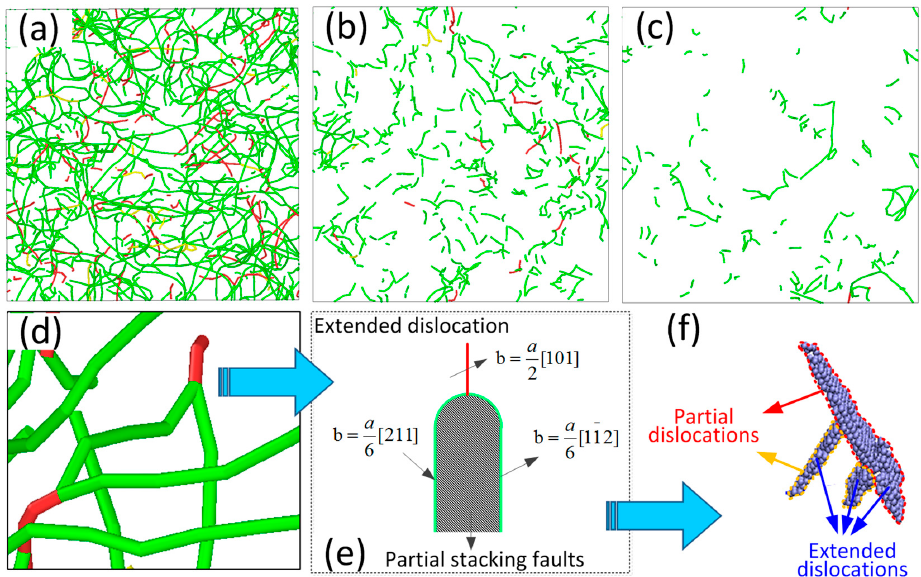
Figure 12. Analysis for the dislocations generated by LSW under different temperatures. ( a ) 293 K, 4 ps; ( b ) 473 K, 4 ps; ( c ) 673 K, 4 ps; ( d ) extended dislocations; ( e ) Burgers vectors of extended dislocation; and ( f ) extended dislocation atoms.